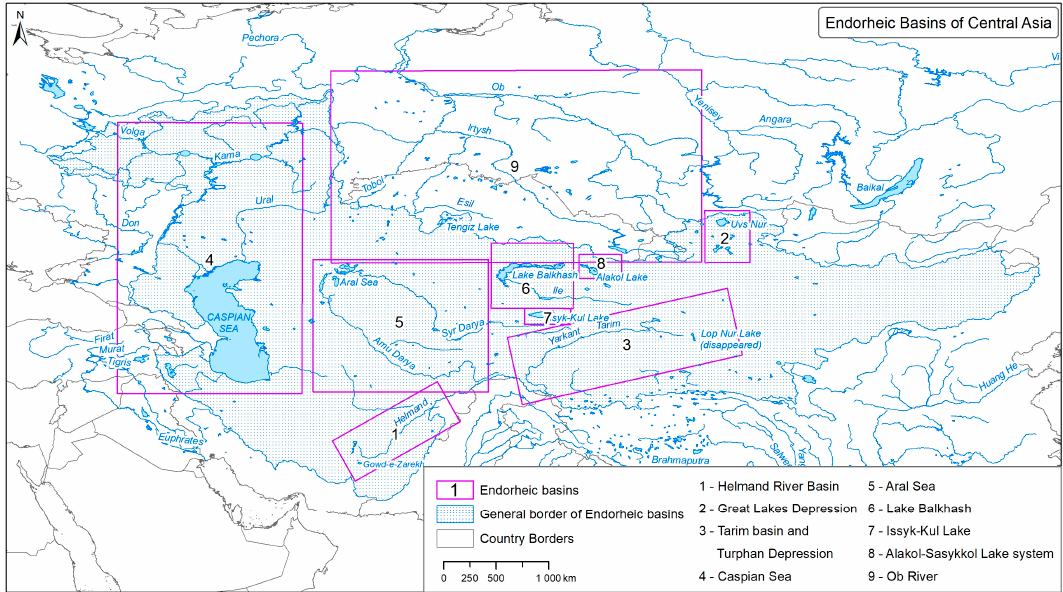
Figure 2. The endorheic basins and lakes of Central Asia.